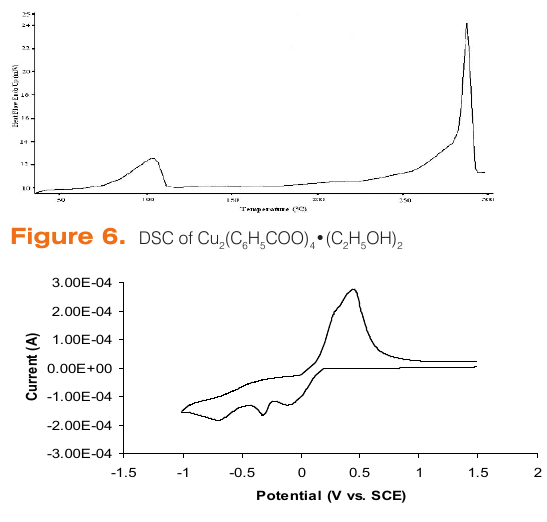
Figure 7. Cyclic voltammogram of Cu